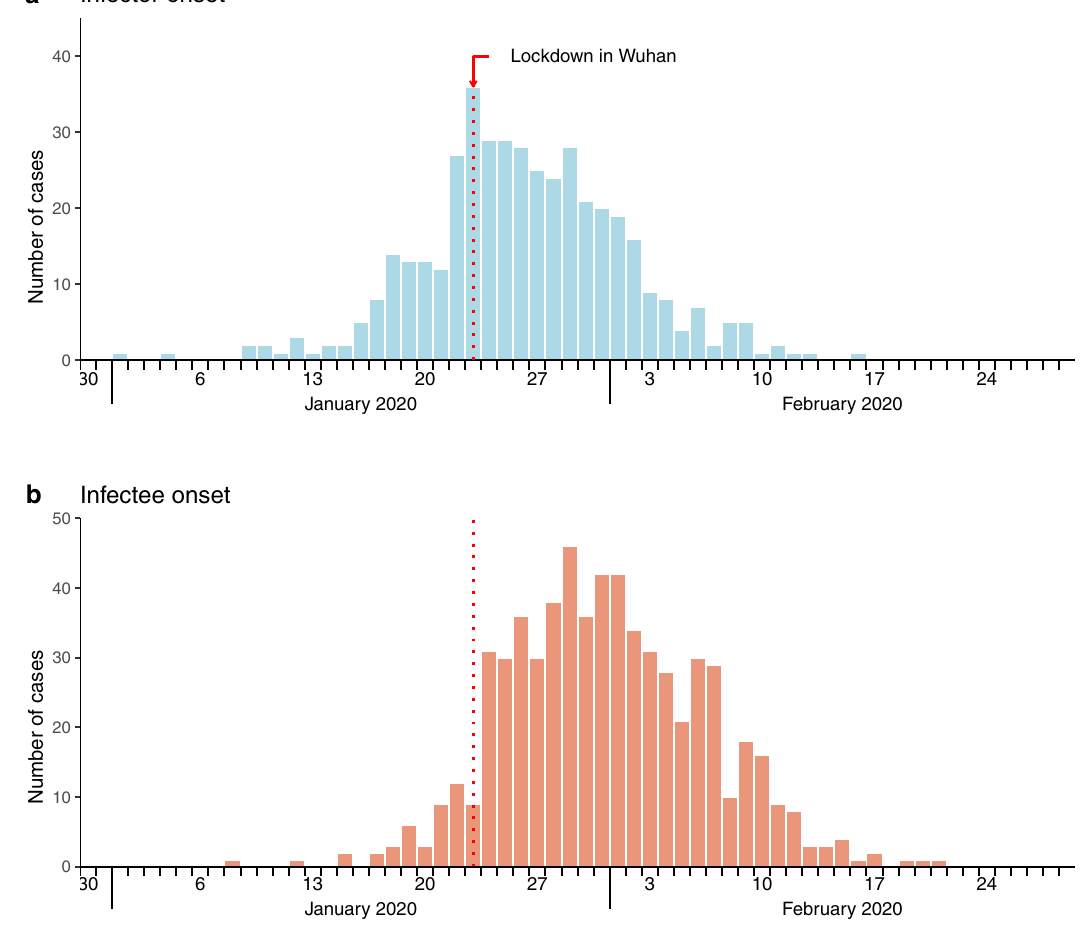
Fig. 1 | Infector – infectee speci fi c symptom onset epi-curves from January 1 to February 29, 2020 in Mainland China. a Epidemic curve based on symptom onset timing for the daily number of infectors. b Epidemic curve based on symptom onset timing for the daily number of